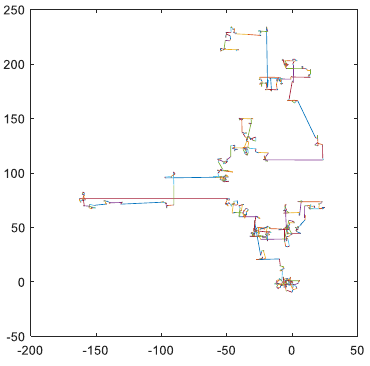
Figure 3. Simulation of a Levy flight path in the 2D plane.